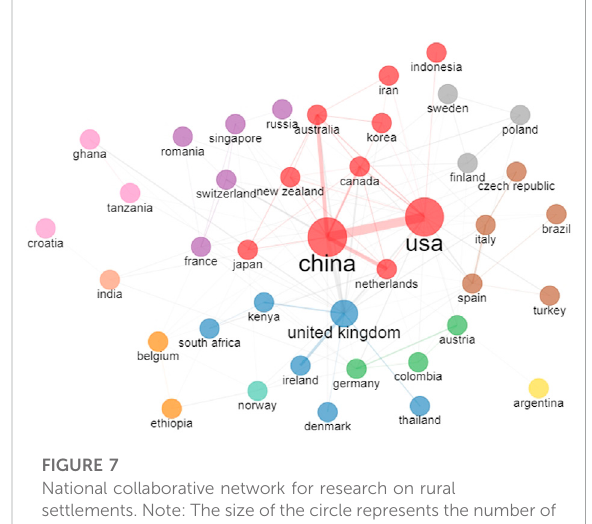
National collaborative network for research on rural settlements. Note: The size of the circle represents the number of articles published in cooperation with other countries, and the thickness of the connecting line represents the number of cooperationbetweencountries; thethicker theline,thecloser the connection between countries.